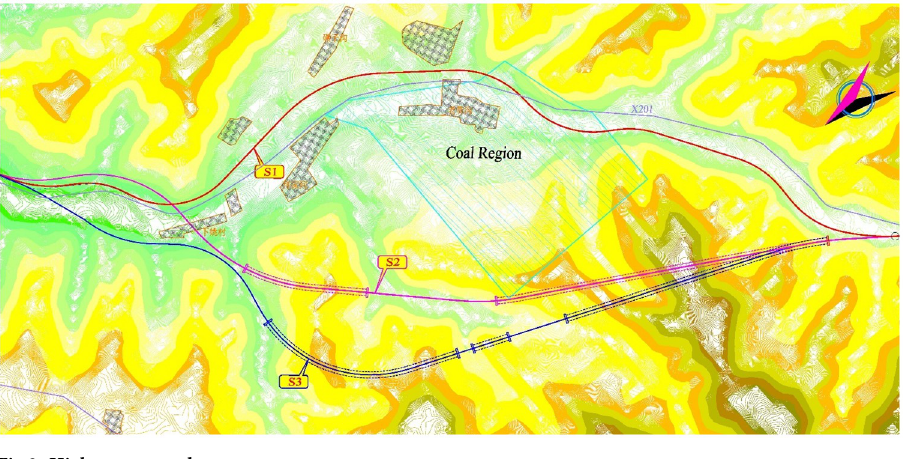
Fig 3. Highway route